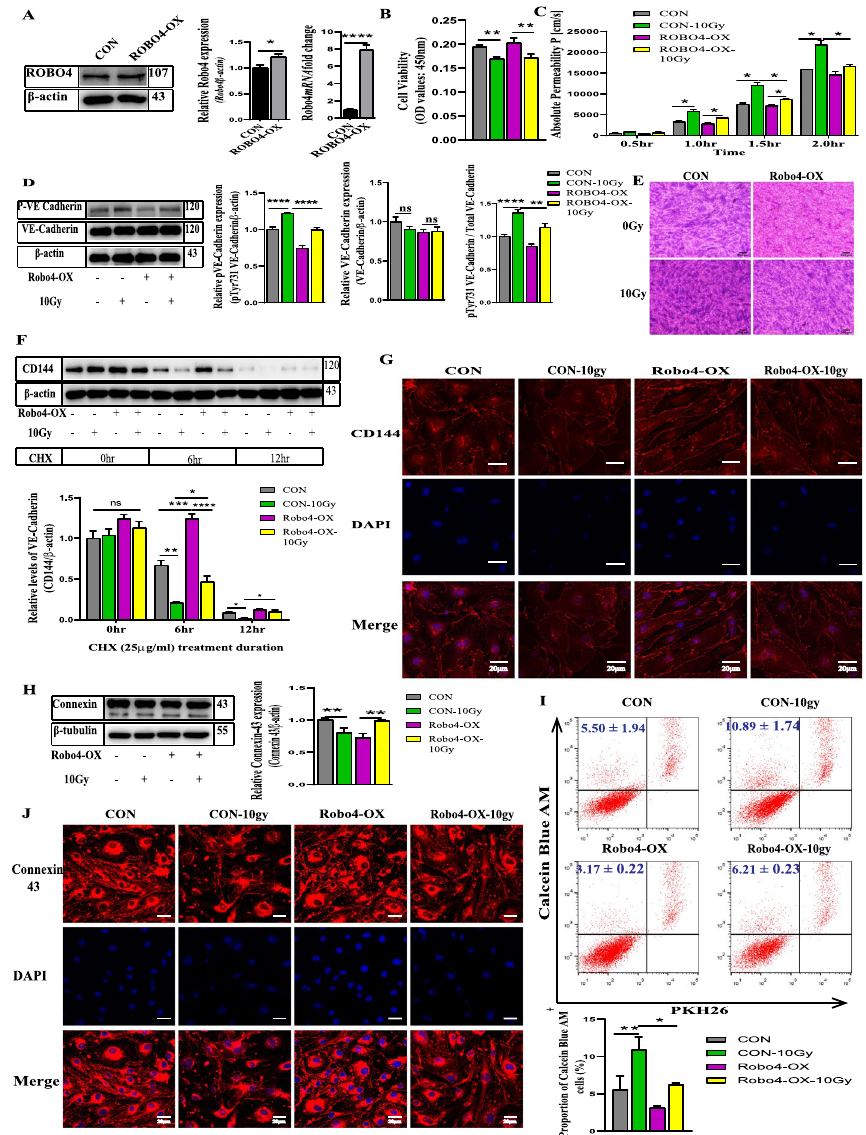
Fig. 4 Overexpression of Robo4 improves IR-induced downregulation of VE-cadherin and decreases the permeability of the EC monolayer. A Confirmation of Robo4 overexpression after establishing a stable cell line using western blot and qPCR analysis, respectively. B Effect of Robo4 overexpression and irradiation on cell survival and proliferation of ECs. C and E Functional analysis of Robo4 overexpression by FITC-dextran (70 kDa) permeability assay and EC monolayer crystal violet staining after irradiation. D Western blot analysis of total and pY-731 VE-cadherin after Robo4 overexpression and irradiation; the relative protein expression of phosphorylated Y-731 and total VE-cadherin normalized with endogenous beta-actin protein; The ratio of pY-731 VE-cadherin to total VE-cadherin. Cycloheximide treatment and immunoblotting were conducted as in ( F ). The CD144 band intensity was normalized to actin and then normalized to the t 0 controls. G = Confocal microscopic images of VE-cadherin (red) and DAPI (blue). H Western blot analysis showing connexin 43 expression levels in Robo4 overexpression microvascular ECs after gamma radiation treatment. J Confocal images show immunofluorescence of connexin 43 (red) in Robo4 overexpression microvascular ECs, with or without irradiation. Nuclei appear in blue. I Flow cytometric analysis to determine EC GJ coupling ability in vitro. For all experiments, scale bars 20 µm, n 3, and error bars represent std. * P < 0.05, ** P < 0.01, = ≥ *** P < 0.001, **** P <